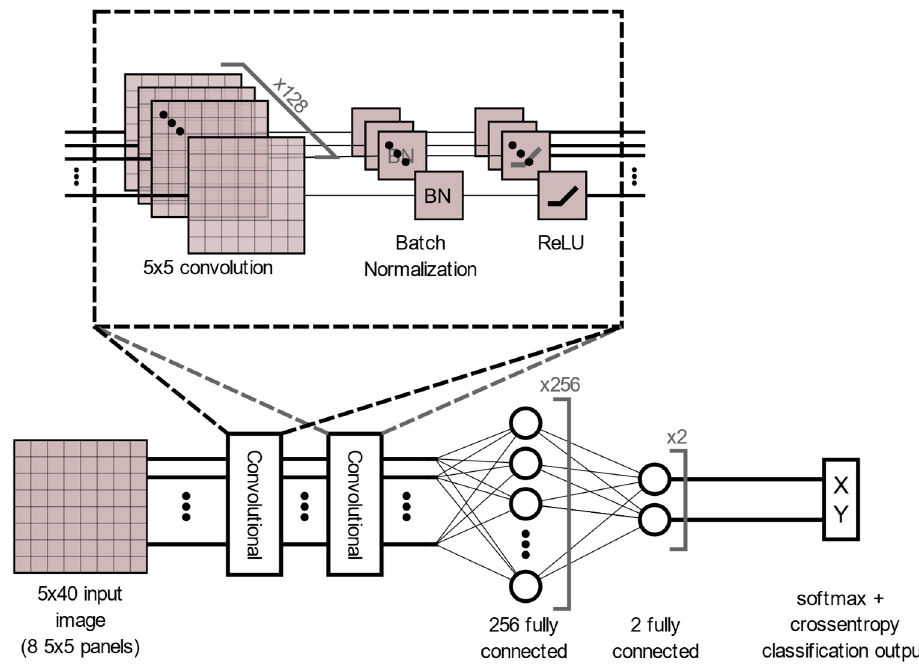
Figure 8. Best Performing Gender Classification Structure: CNN.